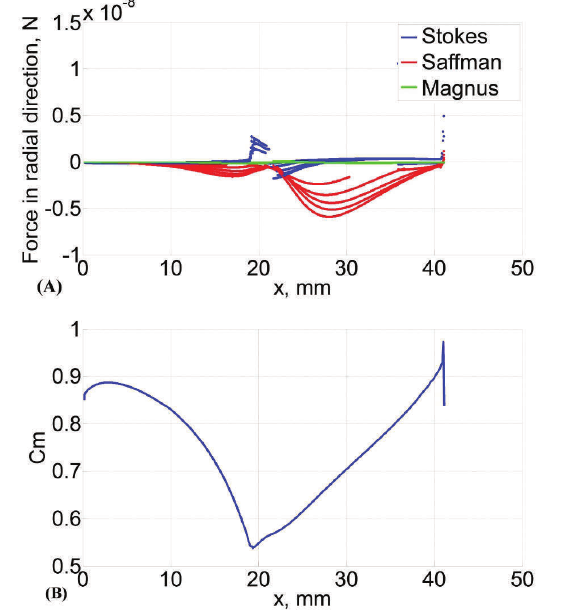
Figure 12. Graph of (A) the radial component of Stokes, Saffman, and Magnus forces, and (B) Magnitude of C M for the aerosol particles flowing through a converging- diverging nozzle.